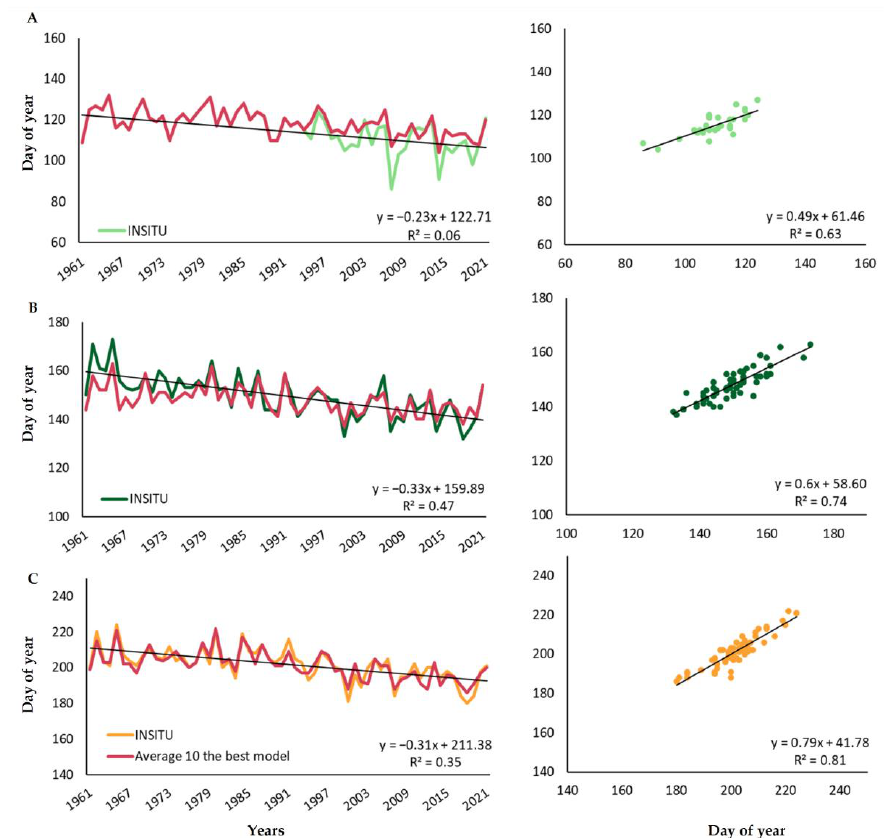
Figure 2. Comparison between the observed and modeled jointing ( A ), heading ( B ), and full ripeness ( C ) phenophases for Chrlice station. The red curves in the line graphs represent the modeled onsets of phenophases in the period from 1961 to 2021, and the colored curves (light green, dark green, and yellow) represent the ground-observed onsets of phenophases. Table 4. The average RMSE values describe the accuracy with which the model calculated the onsets of jointing, heading, and full ripeness phenophases. The lowest average RMSE values are highlighted with a gray background. Thr-0 to Thr-0.6 are the thresholds of the Z-score for the model with SOS, NDVI is the normalized difference vegetation index, and EVI2 is the enhanced vegetation index 2.